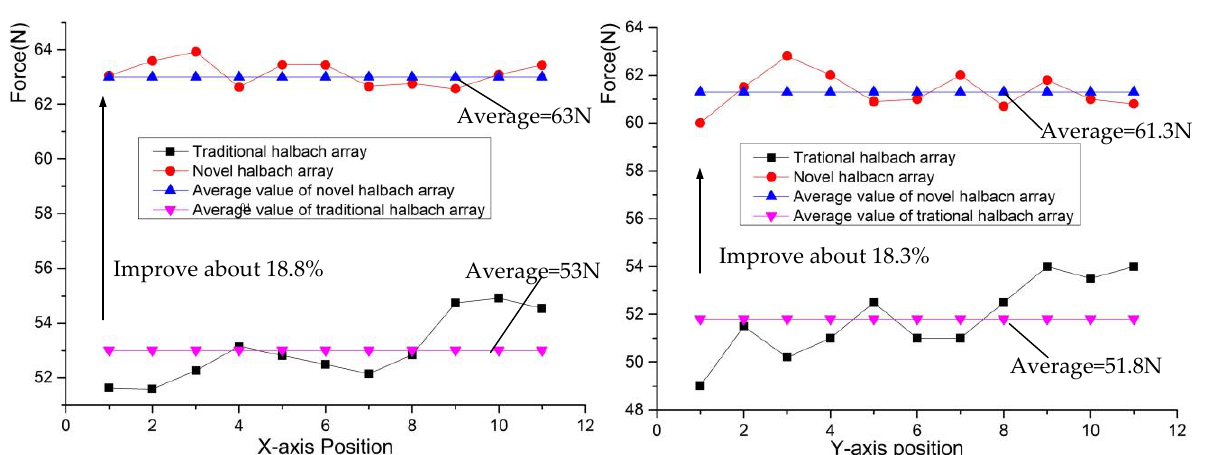
Figure 12. Relationship between the driving force and the actuator’s position.